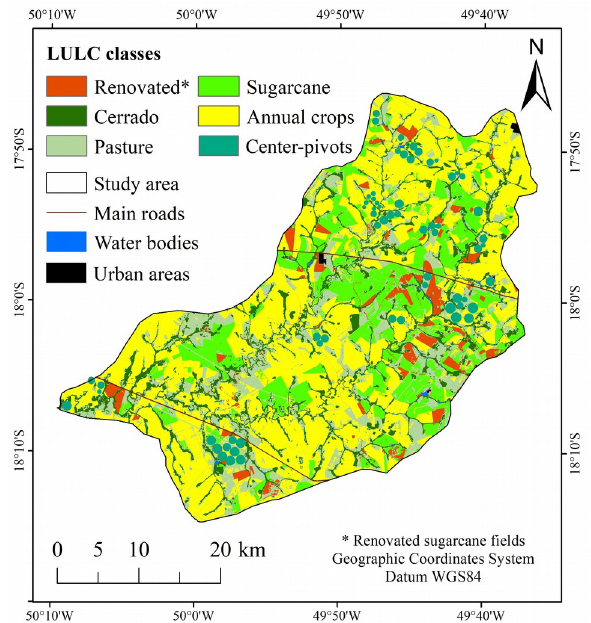
Figure 3 . Final map produced through the Random Forest classification with the Harmonized Landsat 8 Sentinel-2 multispectral dataset, showing the target classes and masked areas.